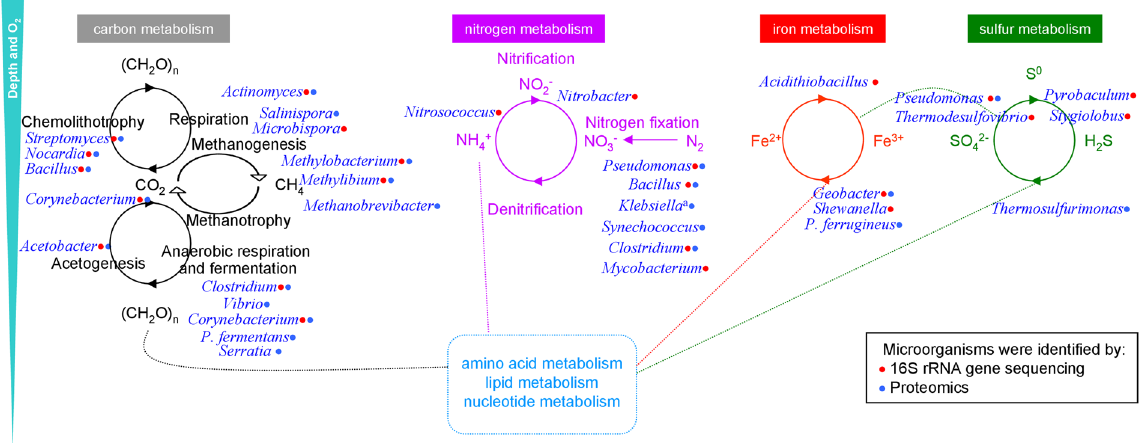
Figure 6. Overview of the metabolic potentials between dominant microorganisms in the englacial ecosystem of Mount Pond glacier. Representative microorganisms identified by 16S rRNA gene sequencing and by Proteomics. a Nitrogen fixation occurs only under anoxic